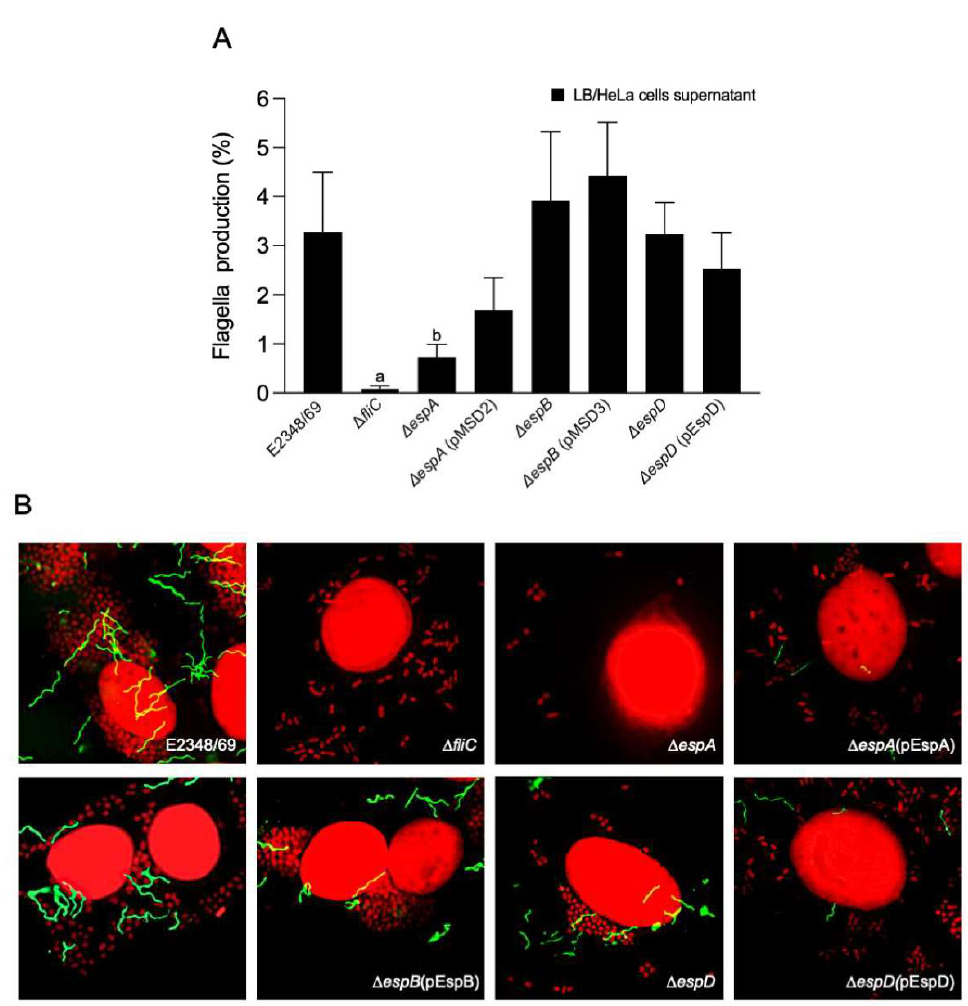
Figure 1. Production of flagella by EPEC strains defective in T3SS. ( A ) Flow cytometry was used to quantitatively determine flagella production. LB-grown bacteria were used to infect HeLa cells for 3 h after which the supernatants were collected and analyzed by flow cytometry using rabbit anti-H6 antibodies and anti-rabbit IgG Alexa–fluor 488. The data shown are the mean of three experiments performed in triplicate on different days. Letters a and b show statistical significance of the mutants tested with respect to E2348/69 (one-way ANOVA test, followed by Tukey’s multiple comparison), a = p < 0.001; b = p < 0.01. ( B ) Flagella produced by the indicated LB-grown bacterial strains adhering to HeLa cells were visualized by immunofluorescence using rabbit anti-H6 flagella antibodies and anti-rabbit IgG Alexa-fluor 488. Immunofluorescence images were taken at 60 × . In contrast, the ∆ espB and ∆ espD mutants showed no statistical differences in flagella production with respect to E2348/69. As expected, the ∆ fliC mutant showed no